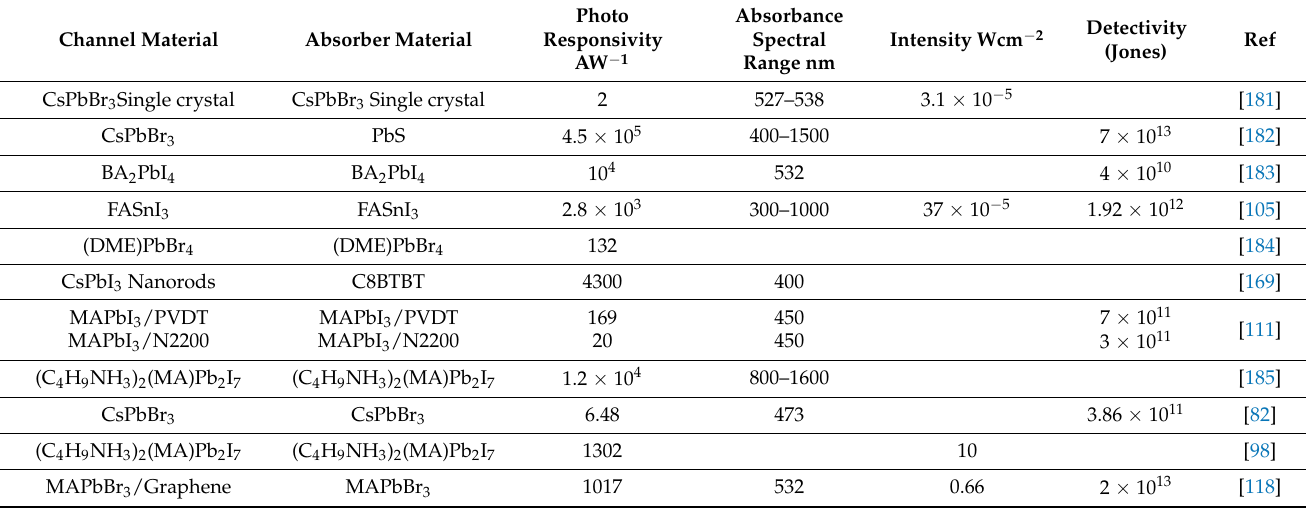
Table 6. The works of Perovskite thin-film FET-based Photo detectors in the literature.